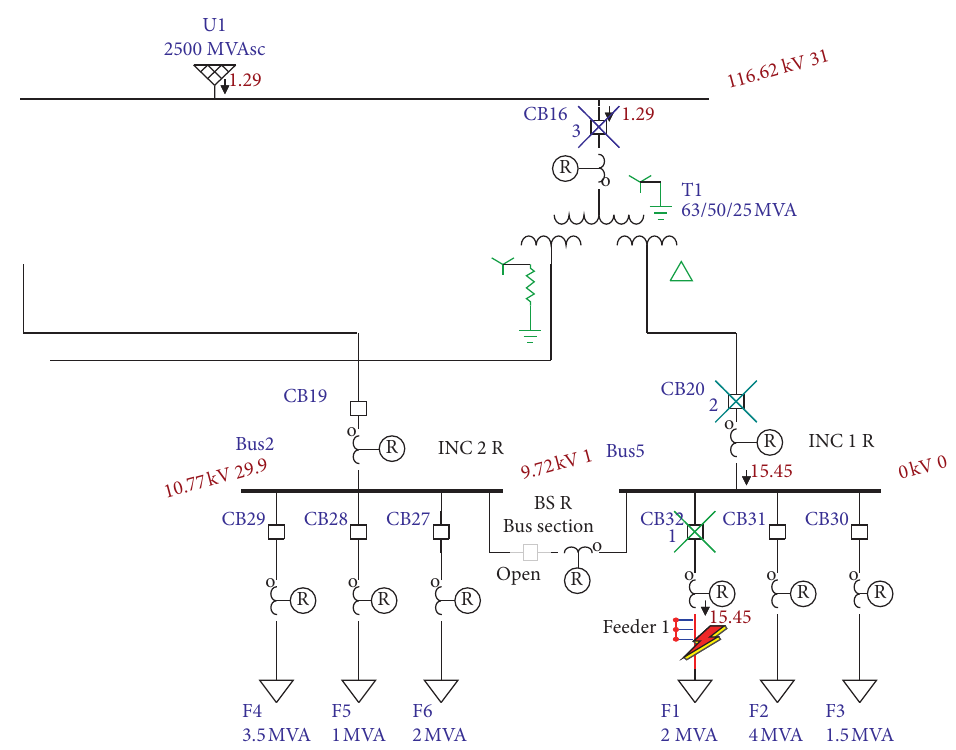
Figure 11: Relays operation sequence for feeder 1 fault with bus section CB, OFF.